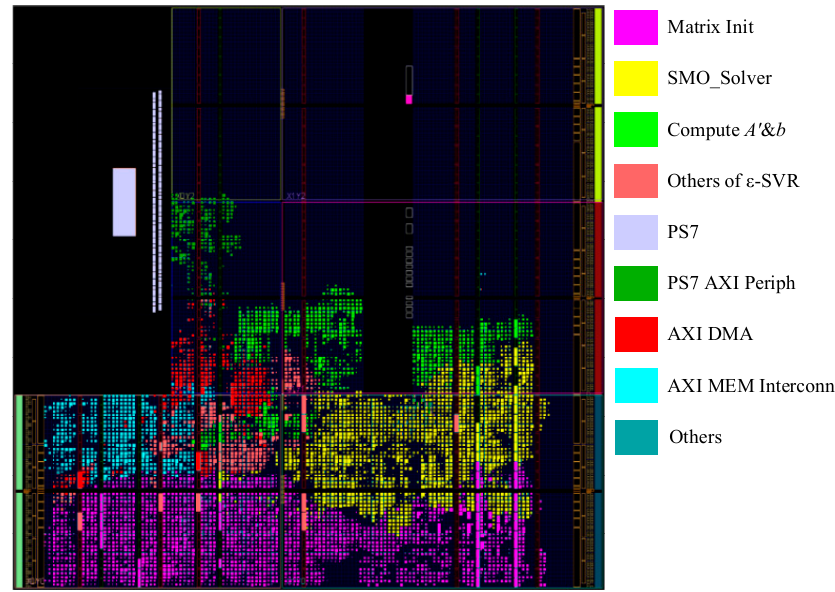
Figure 13. Place and route of proposed system.